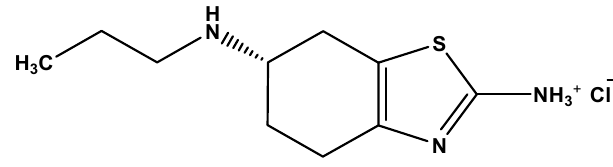
Figure 1. Chemical structure of pramipexole